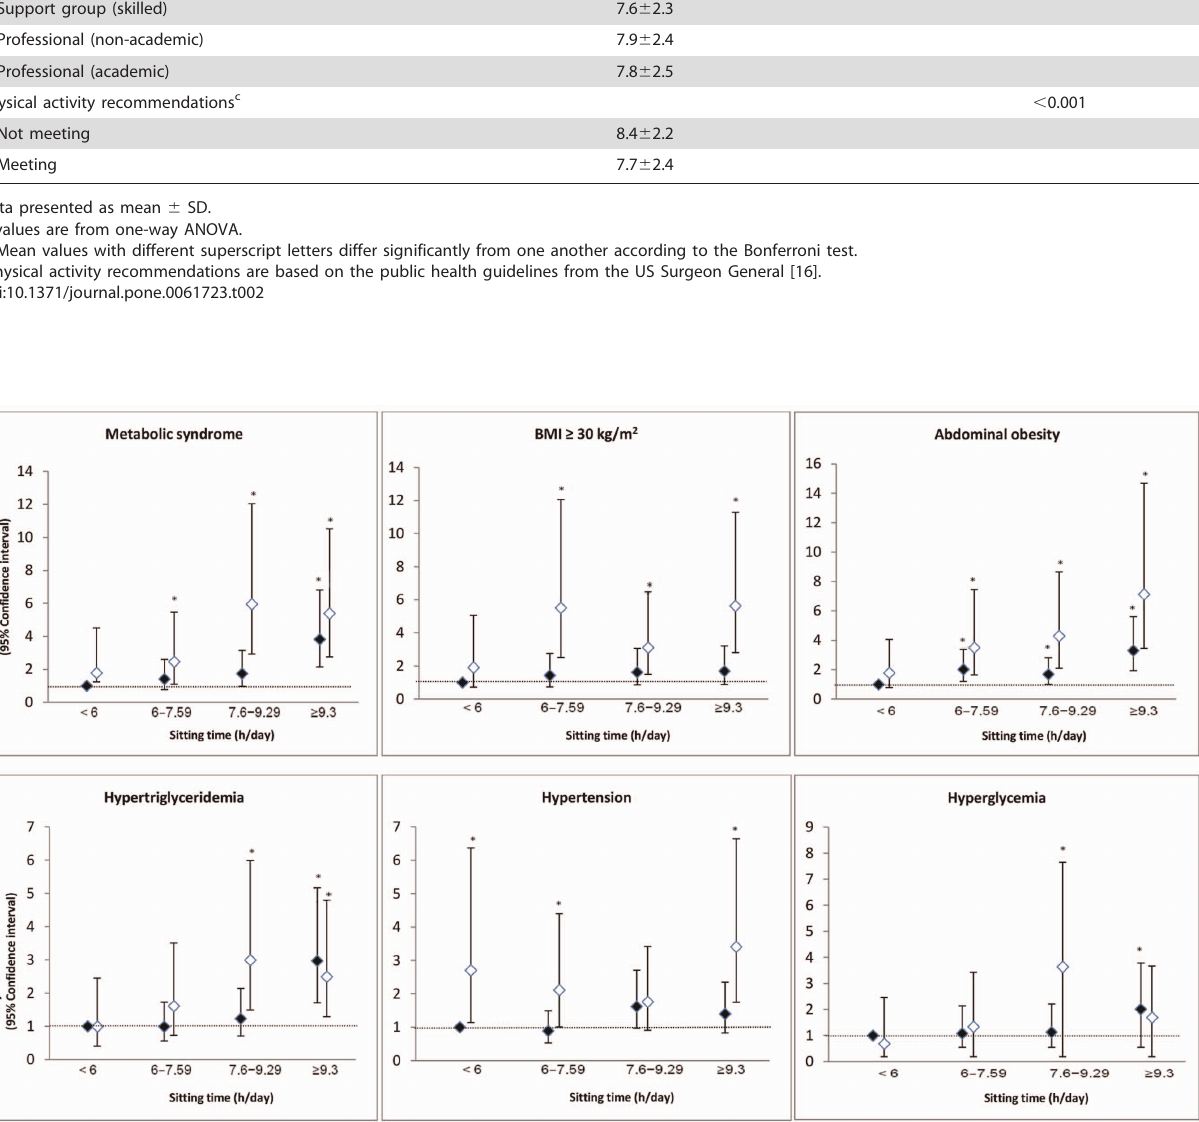
Figure 1. Joint association of sitting quartiles and physical activity levels for metabolic risk factors. Error bars indicate 95% CI. The referent group comprises participants with the lowest sitting quartile ( , 6 h/day) and being physically active. Analyses were adjusted for gender and educational level. *Significant difference (p , 0.05) compared to referent group. Physical activity level ¤ Active e Inactive.